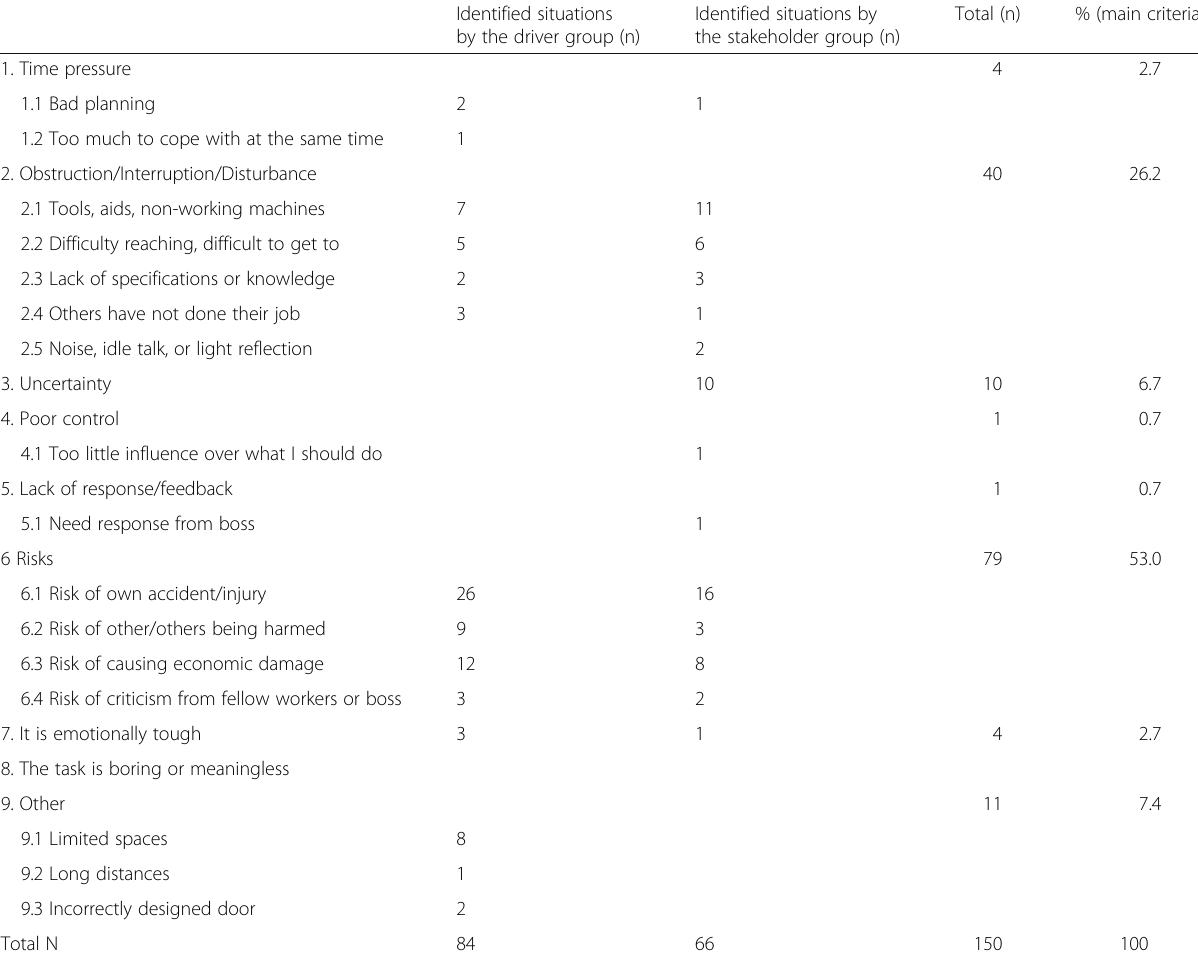
Table 1 Identified psychosocial discomforts